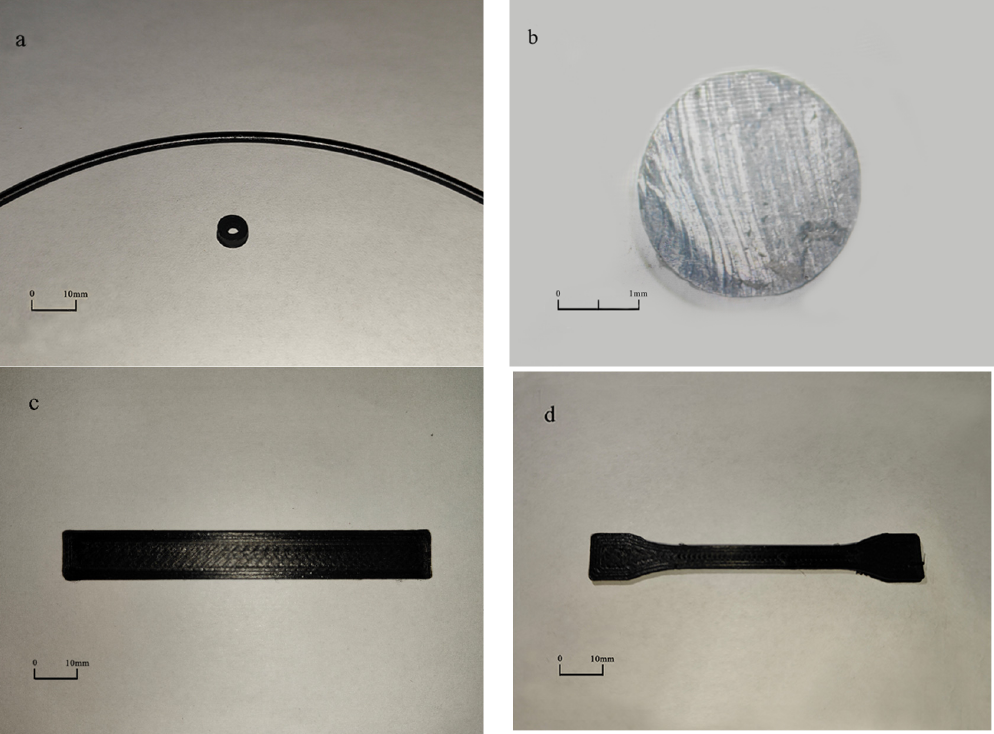
Figure 4. 10 wt.% MWCNT/PA12 composite filament and samples. ( a ) Macro-morphology of filament and printed concentric annular-shaped sample. ( b ) Cross-section of filament. ( c ) Printed straight sample. ( d ) Printed dumbbell sample.